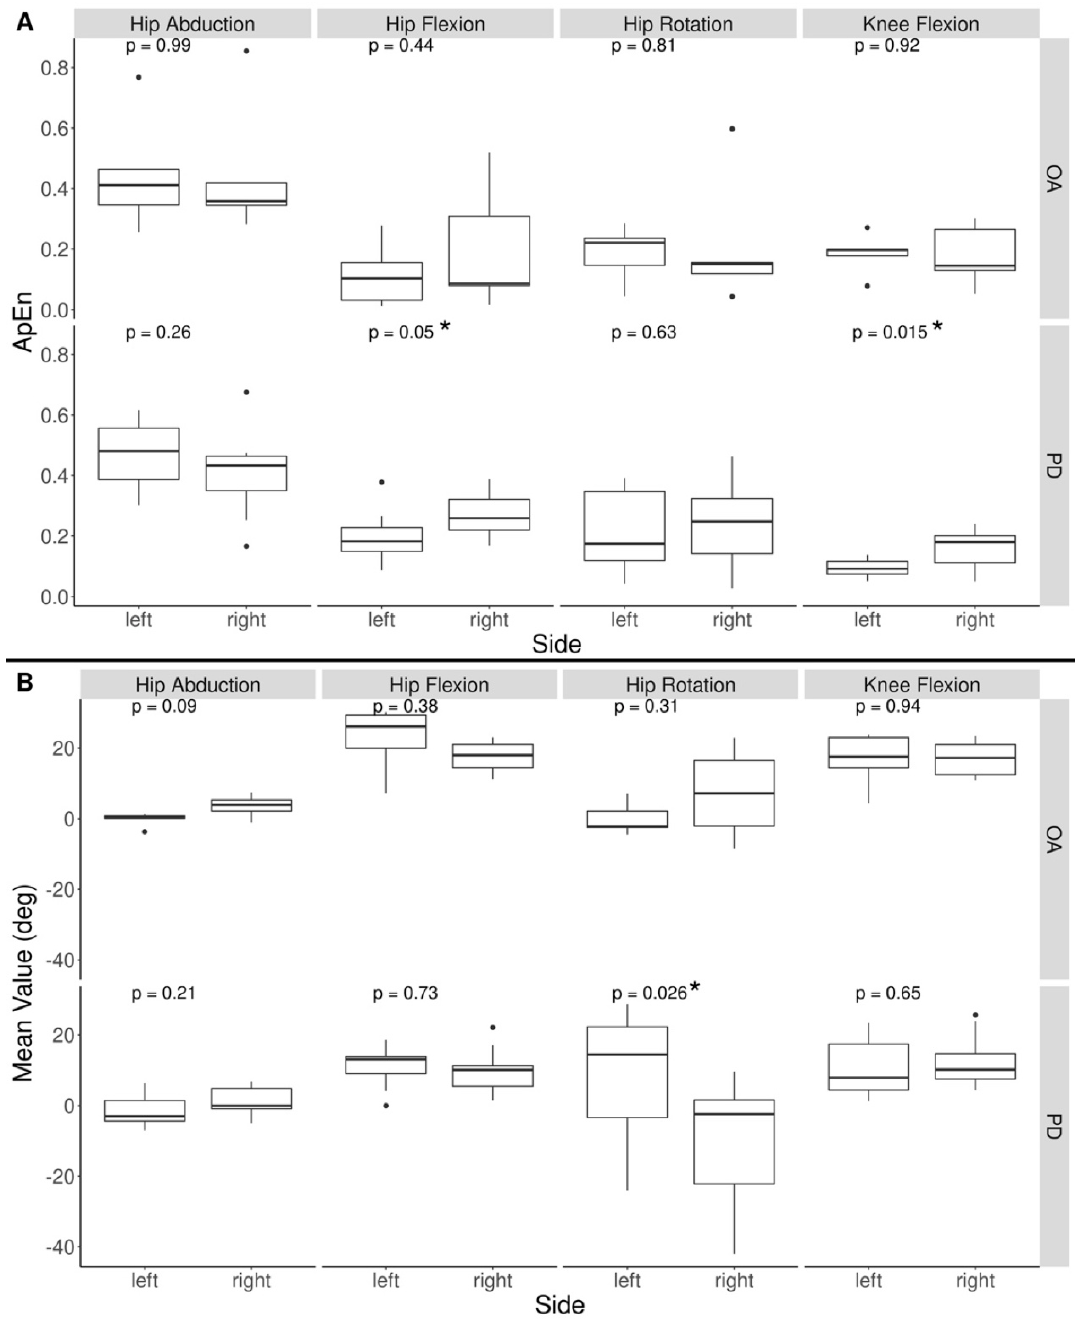
Figure 6. Left vs. right ApEn of body movement in PD and OA ( A ). Boxplot of ApEn values where each datapoint represents the mean ApEn of all recordings for a specific dance and specific participant. No significant difference was found between left and right ApEn of movement in the OA group. The PD group had higher ApEn of right knee flexion and hip flexion than left. Left vs. right mean body movement in PD and OA ( B ). No significant difference was found between mean left and mean right body movements in OA, however PD saw a significantly higher left hip rotation than right. * indicates measurements with a significant difference in ApEn between left and right knee flexion and hip flexion for PD participants, and a significant difference in mean left and right hip rotation for PD participants.